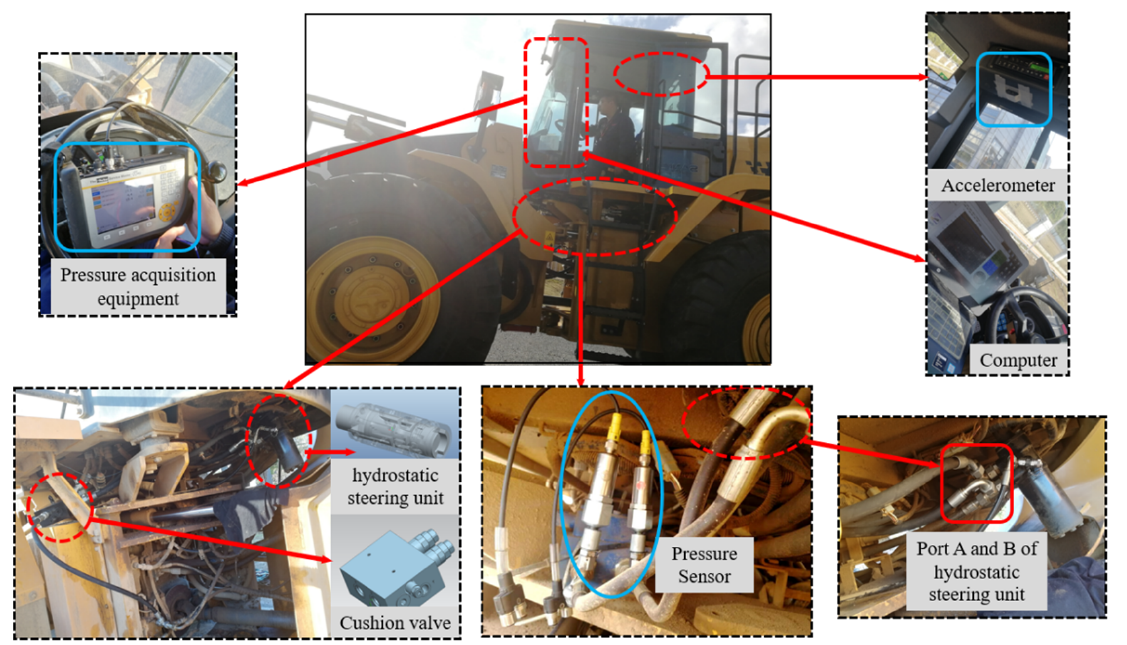
Figure 12. Layout of the test device.